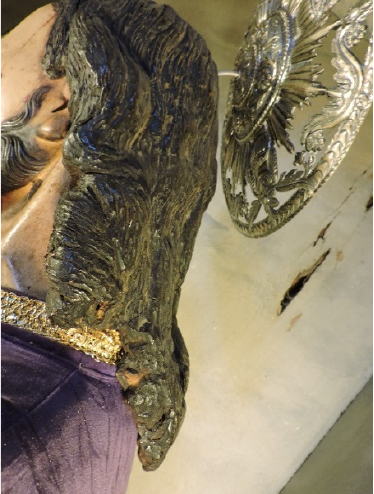
Figure 8. Detail of the space between the hair and the back for the fit of the garment. Photo by Lia Brusadin, 26 December 2016.